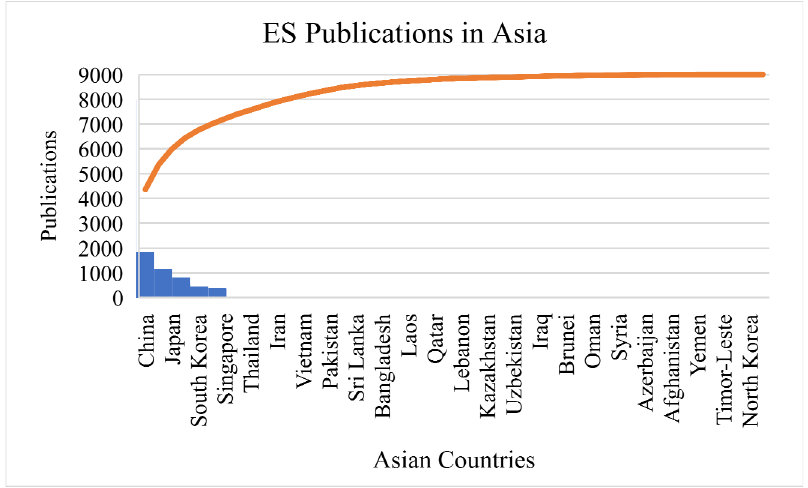
Figure 7. Trend of Asia’s ecosystem service publications.